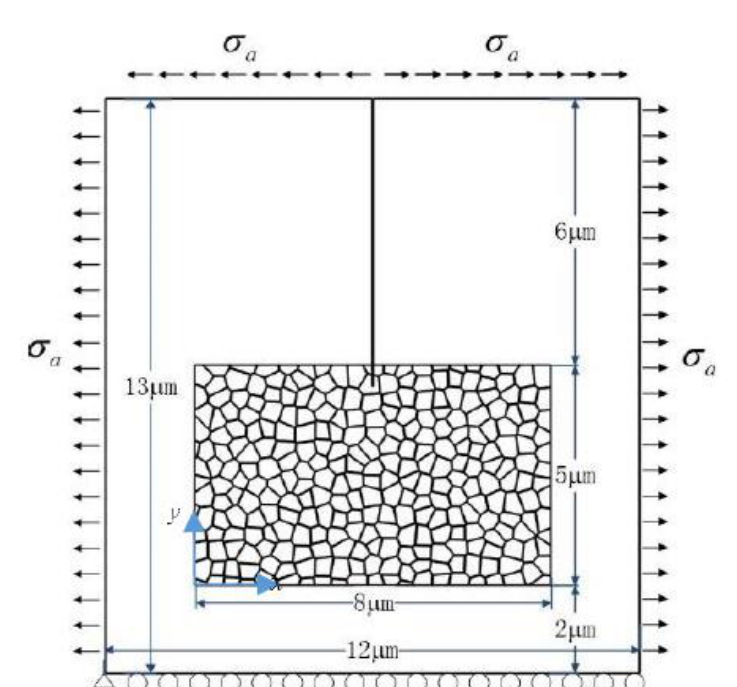
Figure 1. The polycrystal model and the boundary conditions.